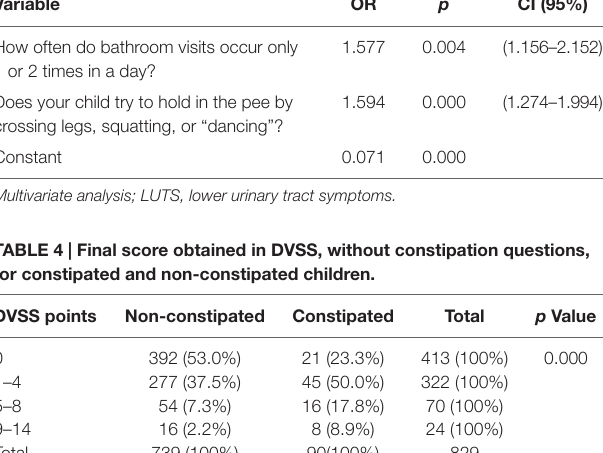
TaBle 3 | Multivariate analysis of urinary symptoms present in constipated children. Variable Or